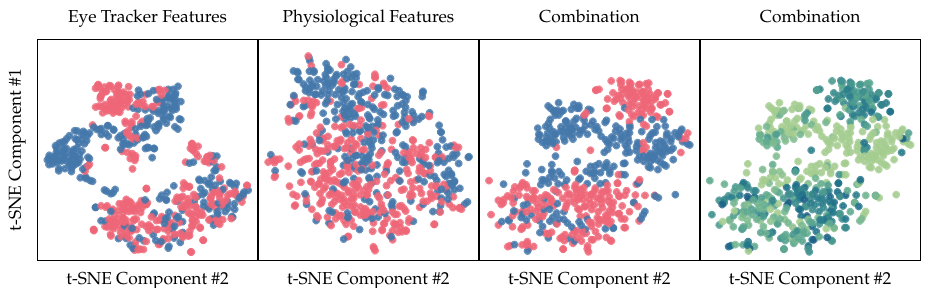
Figure 14. Visualization of 2-component t-SNE representations for computed biosignal- and eye- tracker-based features. The first plot shows t-SNE representation with eye-tracker features only, the second plot depicts only biosignal-based features and the third plot visualizes the combinations of both feature sets. The last plot presents the same representations from the third plot, but color coded as a linear combination of reaction time, recall and NASA-TLX score as color